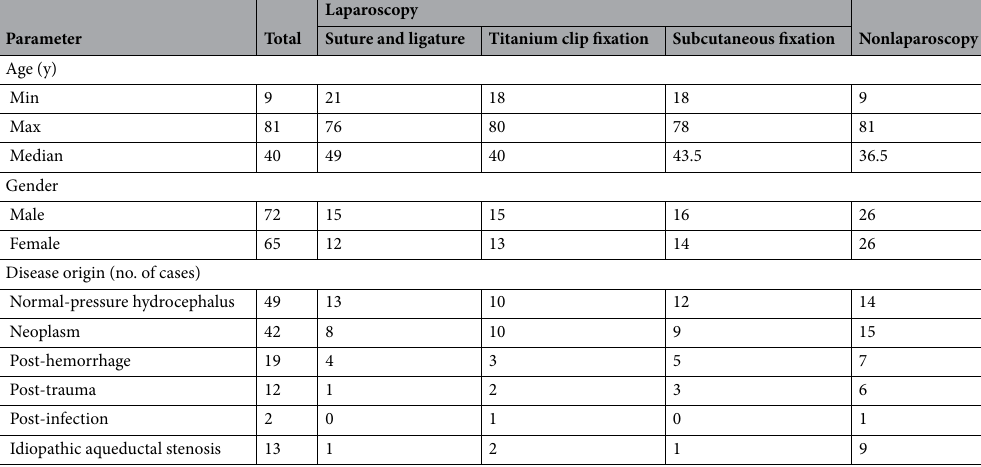
Table 1. Demographic data and origin of hydrocephalus in 137 patients in the laparoscopy group.